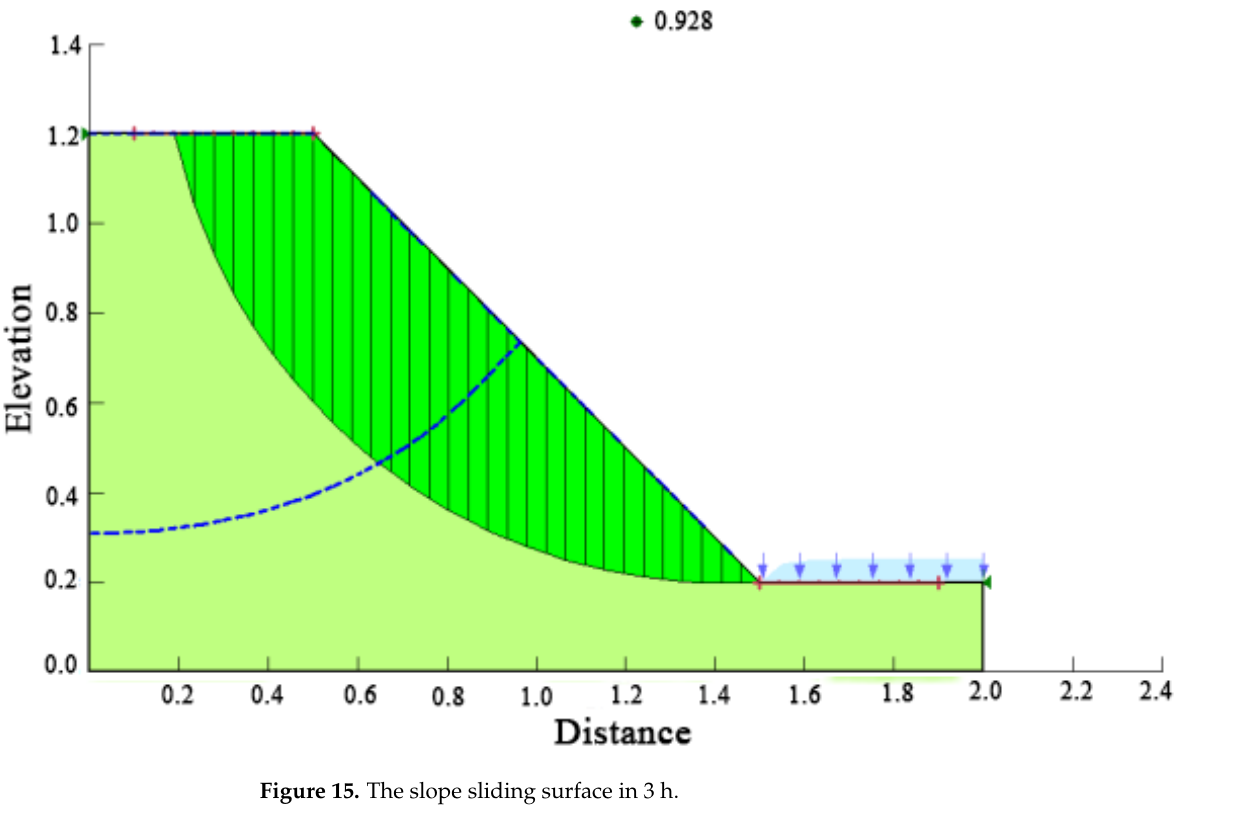
Figure 15. The slope sliding surface in 3 h.